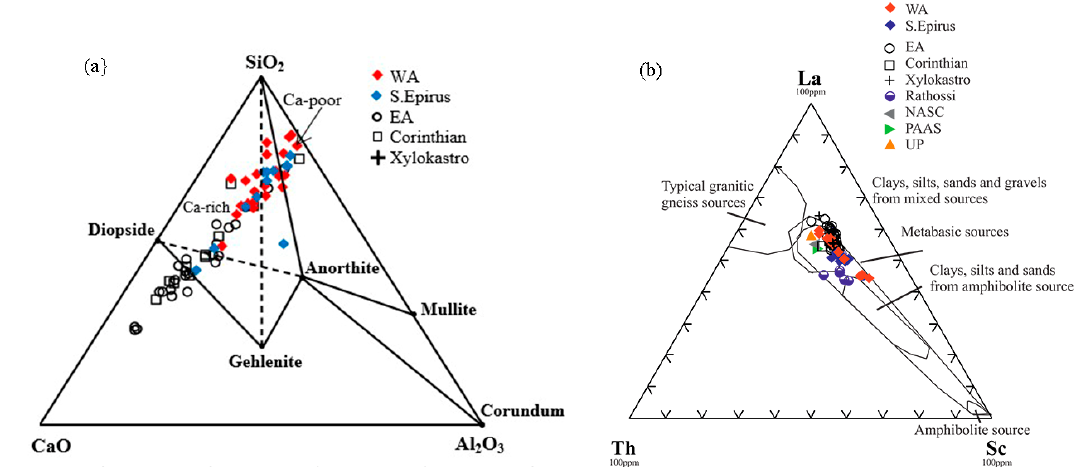
Figure 7. ( a ) Plot of the chemical data of the studied samples on the ternary diagram Al 2 O 3 -CaO- SiO 2 (ACS) [23], and ( b ) La-Th-Sc ternary diagram proposed by Cullers [29]. The clayey sediments of western Achaea [32] are also plotted for comparison purposes. Abbreviations: WA: western Achaea; EA: eastern Achaea; PAAS = Post-Archean Average Shale; UP = Upper Crust (data from [34]) NASC = North American Shale Composite (data from [38,39]). The data for Eastern Achaean, Corinthia, and Xyloakastro and for other sites of WA are given elsewhere [7,12]. Table 4. Elemental concentrations (wt.%, water-free basis) obtained through X-ray fluorescence for the clay-rich